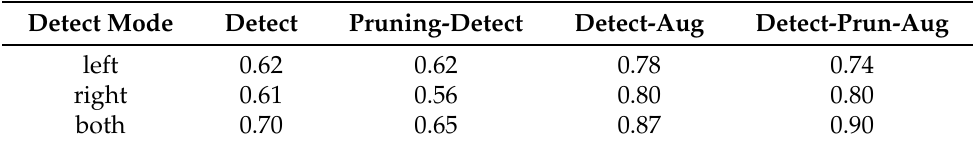
Figure 9. Train dataset of pruned RefineDet: ( a – c ) illustration emphasizing the horns in double side and sparks, respectively, and ( d ) illustration of the augmented frames. Table 2. Detection results for